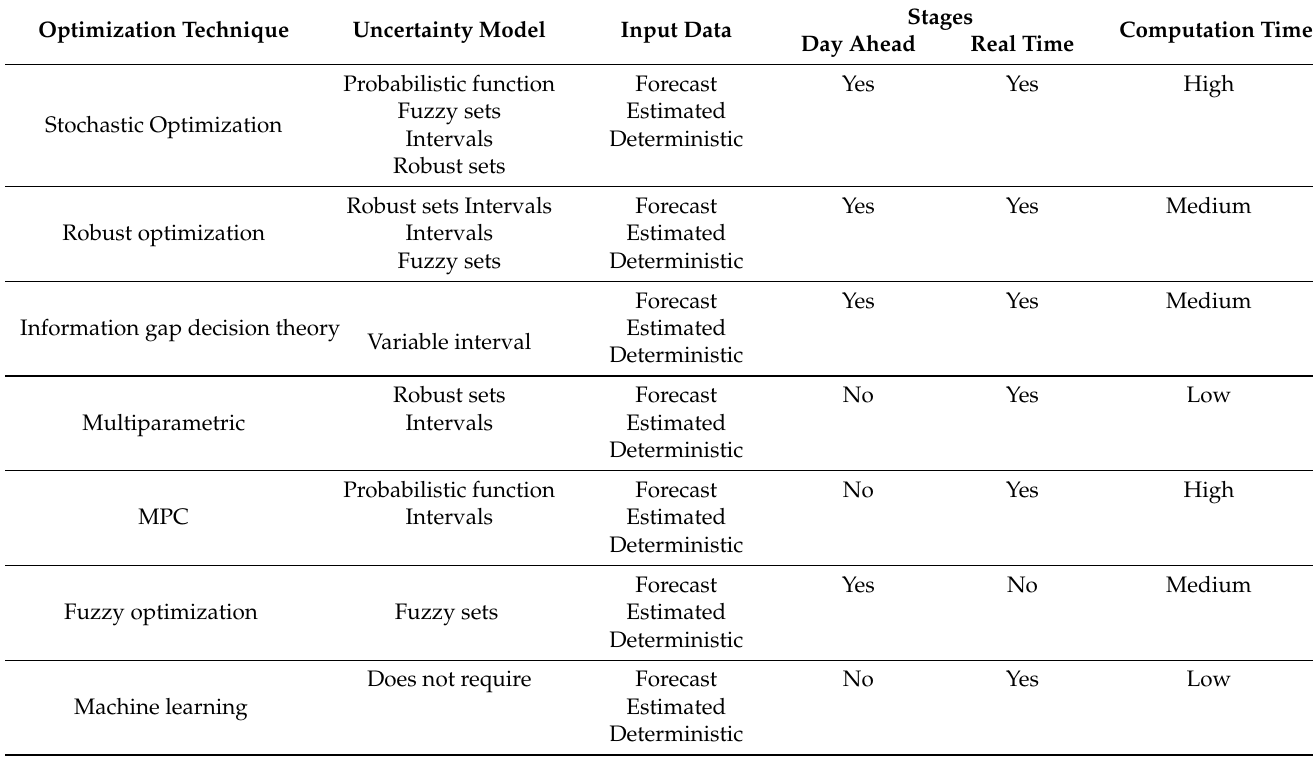
Table 9. Characteristics of the optimization techniques for microgrids under